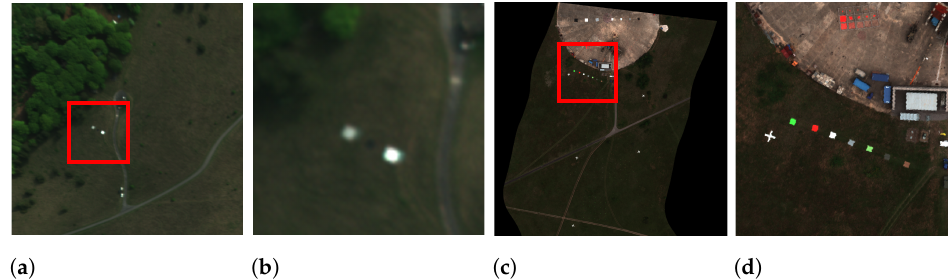
Figure 1. False colour images from the datasets used in this work. ( a ) OP7 image. ( b ) Target Region of ( a ). ( c ) UDRC Selene image. ( d ) Target Region of ( c